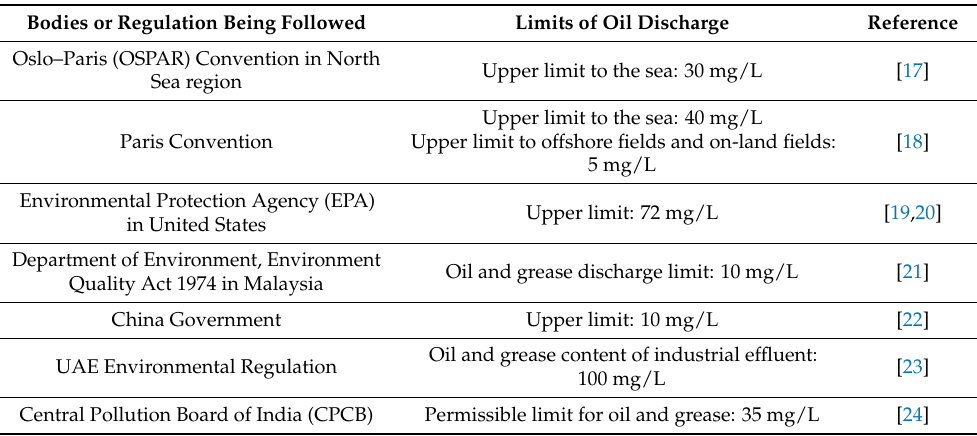
Table 1. Region-specific oil discharge in